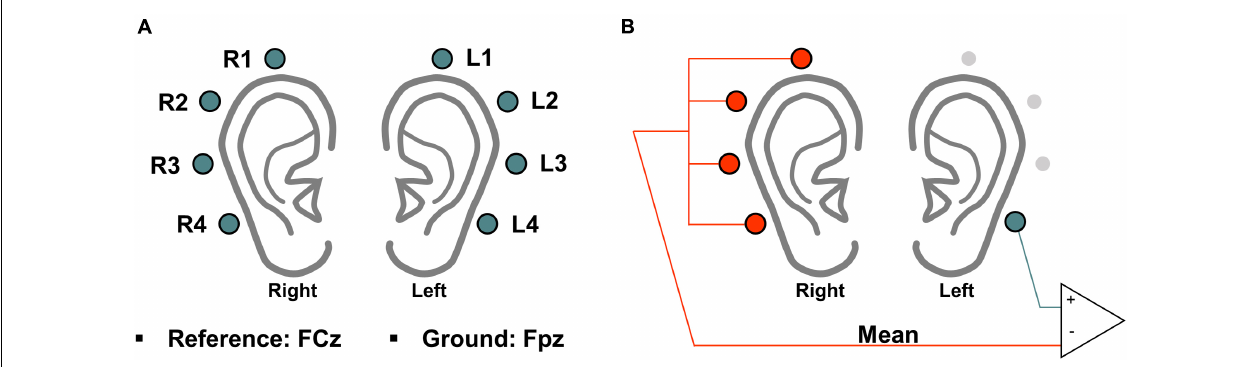
FIGURE 1 | (A) Schematic of electrode positions used to record ear-EEG data. (B) Schematic sketch of the re-referencing method used to remove the impact of the original reference electrode (FCz). Re-referencing was performed by subtracting the mean value of the opposite ear’s electrodes from the value of an electrode of interest for every time